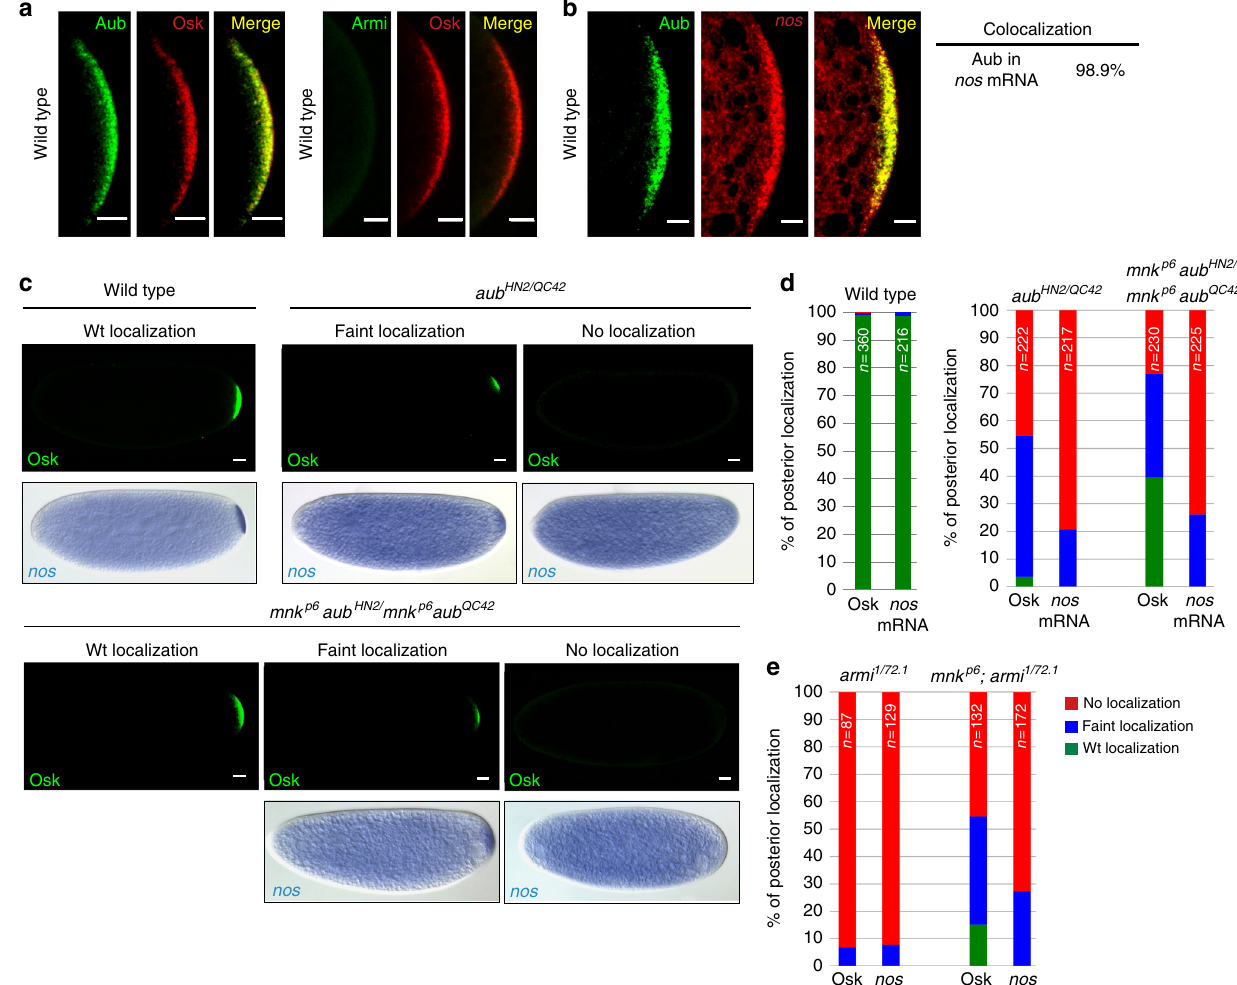
Fig. 1 Aub and Armi have a direct role in nos mRNA posterior localization. a Immunostaining of wild-type 0 – 2 h-embryos with anti-Osk and either anti-Aub or anti-Armi. Posterior poles are shown. b Immuno-FISH of wild-type 0 – 2 h-embryos with anti-Aub and nos RNA probe. Quanti fi cation of colocalization using the Manders coef fi cient is indicated. Scale bars: 10 μ m in a , b . c Immunostaining with anti-Osk and in situ hybridization with nos RNA probe of 0 – 2 h- wild-type, aub mutant or mnk aub double-mutant embryos. Scale bars: 30 μ m. d , e Quanti fi cation of posterior localization of Osk and nos mRNA shown in c for aub and mnk aub mutant embryos, and in (Supplementary Fig. 1b) for armi and mnk ; armi mutant embryos; the legend is in e . For all fi gures, the number of embryos (n) is indicated; the posterior pole is to the